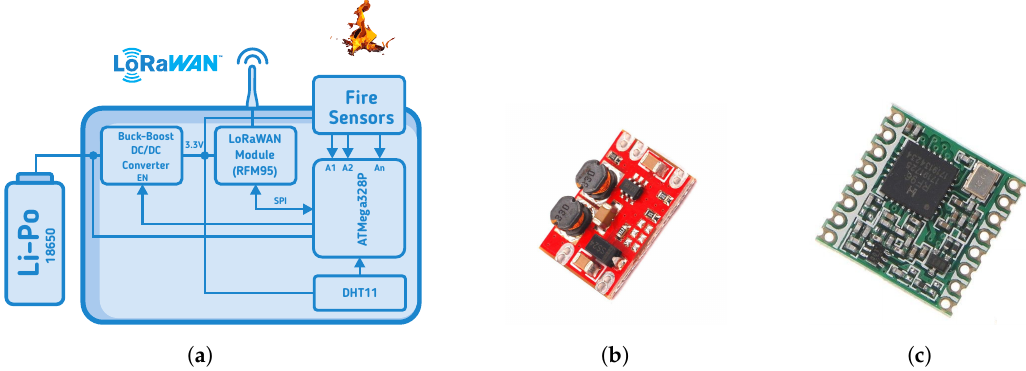
Figure 5. Fundamental components that demonstrate the development of 5FTH. ( a ) Simplified 5FTH PCB layout ; ( b ) DC/DC converter used in PCB; ( c ) RFM96 applied in PCB.